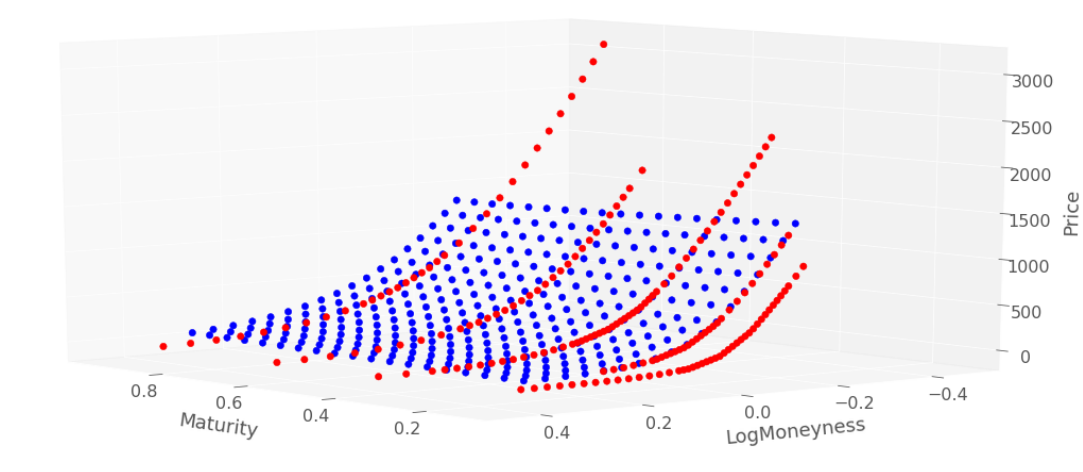
Figure 3. DAX put prices from training grid (red points) and testing grid (blue points), 8 August 2001.